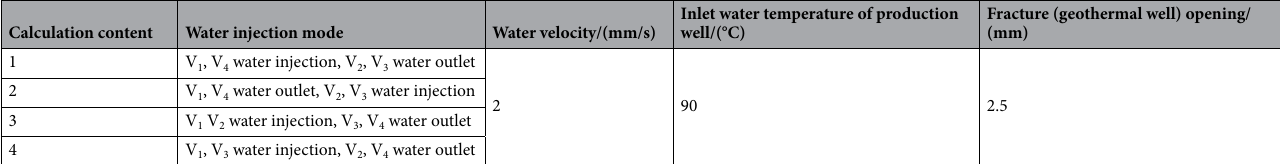
Table 2. Numerical simulation